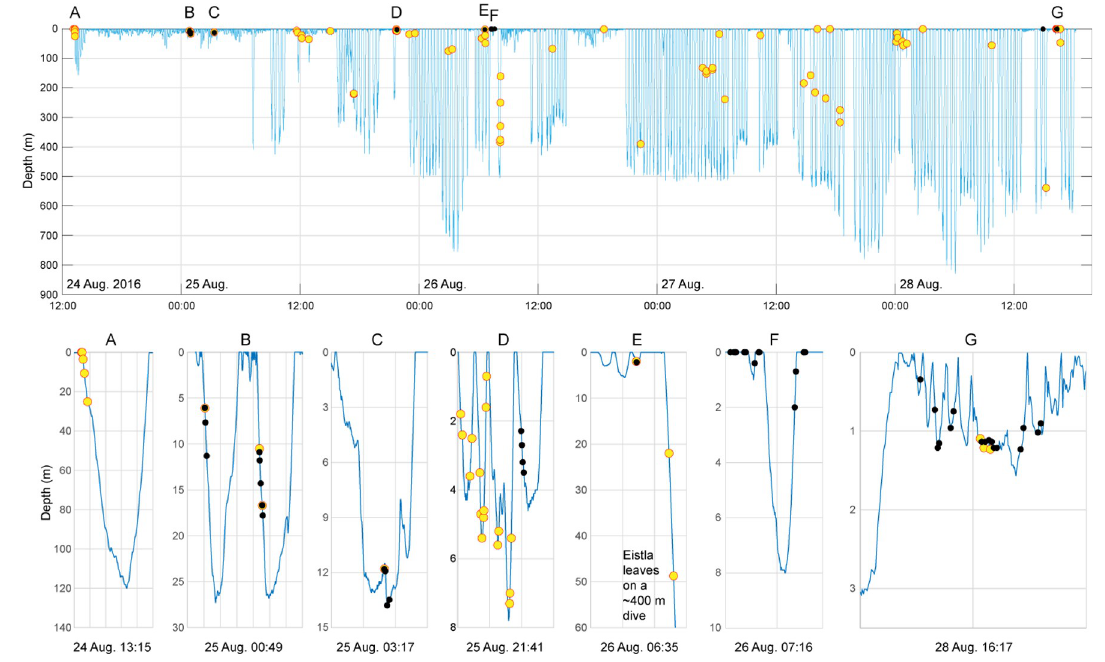
Fig 2. Eistla’s time-depth dive record overlaid with occurrences of type E and C signals. The top panel shows Eistla’s entire Acousonde record. Yellow dots represent type E calls, while black dots represent type C. In subpanels A-G, the x-axis is labeled with the start time and date of each panel, and each vertical interval represents two minutes. Panel A: Type E calls produced immediately following Eistla’s release. Panels B-C: A call and response exchange between type E and C. Panel D: Eistla returns from a ~230 m dive and five type E series (16 calls in the series) are produced while she lingers near the surface followed by one type C series (4 calls in the series). Panel E: One type E call followed by a type C response with type E signals continuing as Eistla leaves on a ~400 m dive. Panel F: Five type C series (14 calls in the series). Panel G: One type C response to a possible other whale (not featured in figure) followed by a type C series, two type C calls with a pulsed sound response (not featured in figured), a call and response exchange between type E and type C, and two type C series. Note that some signals are overlapped and therefore not all signals are clearly visible in the figure.